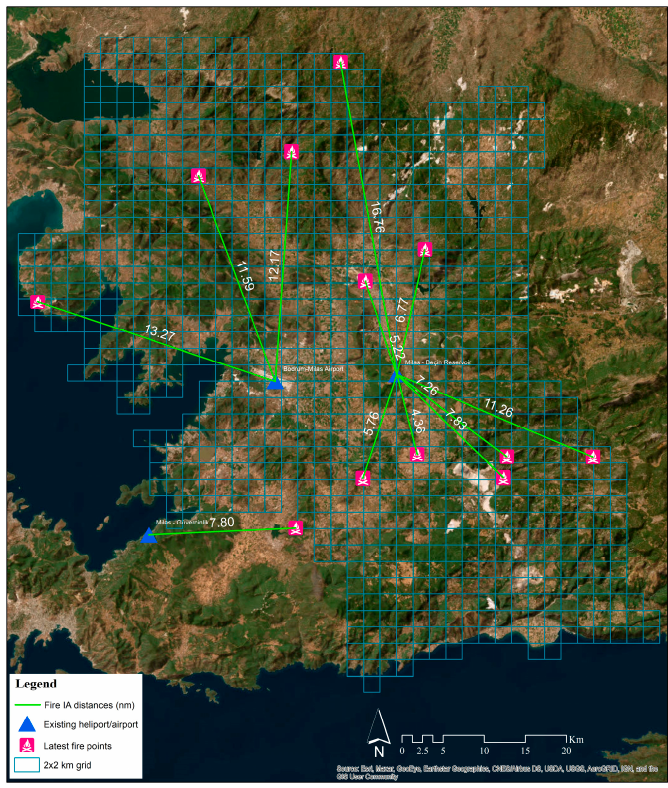
Figure 22. IA times in the current situation.